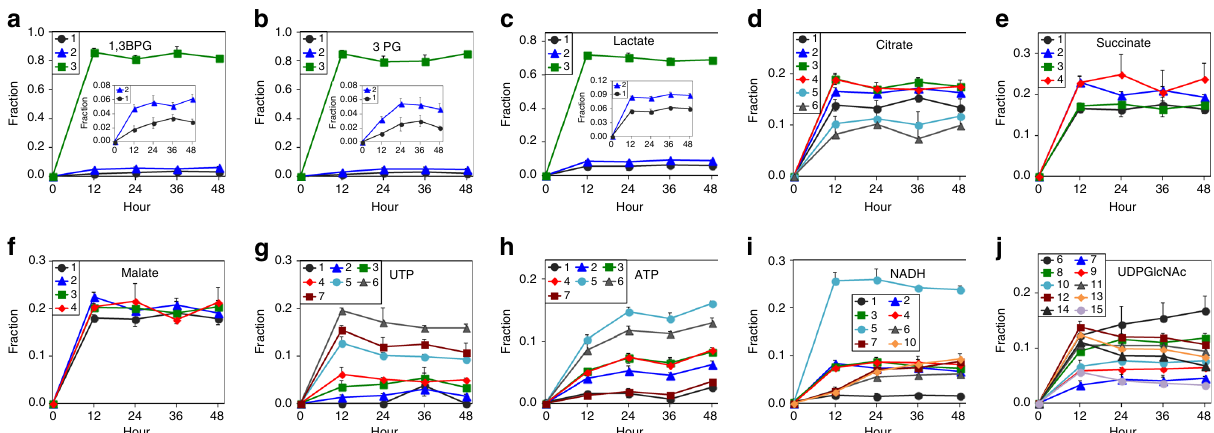
Fig. 2 Time courses of 13 C enrichment of central metabolites in mouse livers fed with 13 C 6 -glucose enriched liquid diet. WT NSG mice were necropsied at 0, 12, 36, and 48 h ( n = 3 at each time point) after feeding with the 13 C 6 -glucose liquid diet. Time courses of the fractional enrichments of 13 C isotopologues (denoted as 1 - 15 , where the number denotes the number of 13 C atoms present) of key metabolites extracted from the liver were determined by IC-UHR- FTMS. Values represent mean ± SEM ( n = 3). Fractional enrichment in the 13 C 1 to 13 C 3 isotopologues ( 1 - 3 ) of the glycolytic products 1,3- bisphosphoglycerate (1,3-BPG), 3-phosphoglycerate (3-PG) and lactate ( a - c , main panels and insets with expanded Y-scale for the 13 C 1 and 13 C 2 isotopologues) reached steady state by 12 h. Fractional enrichment of the 13 C isotopologues in the Krebs cycle products citrate d , succinate e , and malate f , as well as pyrimidine nucleotide UTP g also reached steady state by 12 h. However the fractional enrichment in some 13 C isotopologues of ATP ( 1 - 7 in h ), NADH ( 7 , 10 in i ), and uridine diphosphate-N-acetylglucosamine (UDP-GlcNAc; 6 , 8 in j ) continued to rise during the 48 h period of tracer